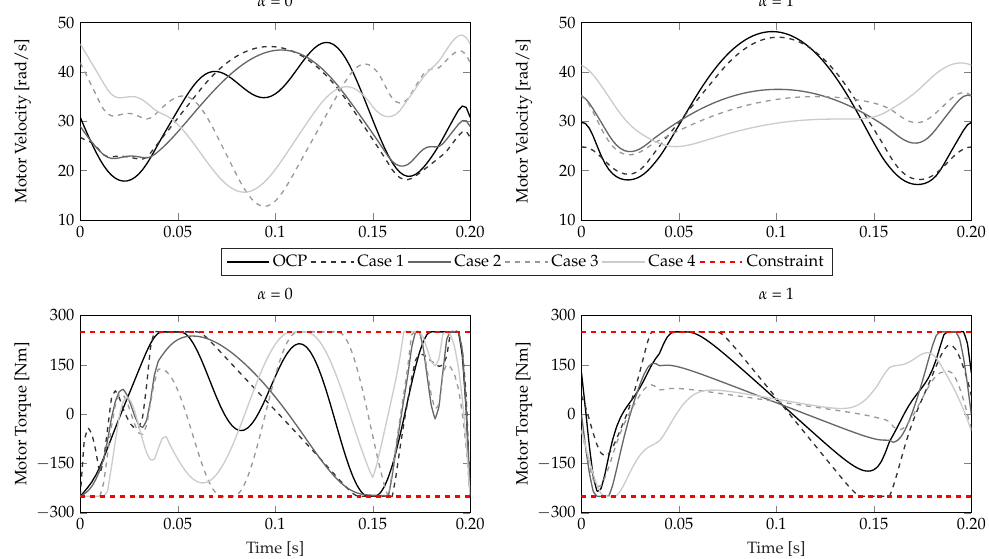
Figure 14. Co-design result: motor speed and